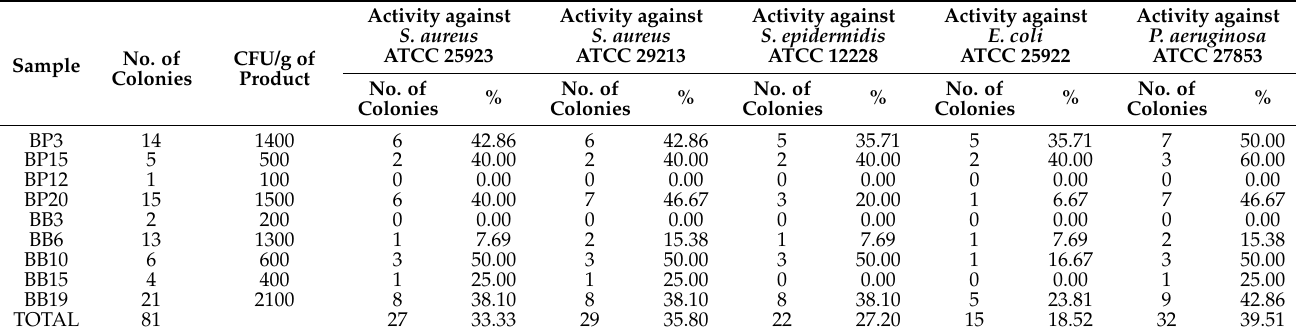
Table 1. Level of microbial contamination of investigated BP and BB samples and the antagonistic activity of isolates against reference strains of pathogenic